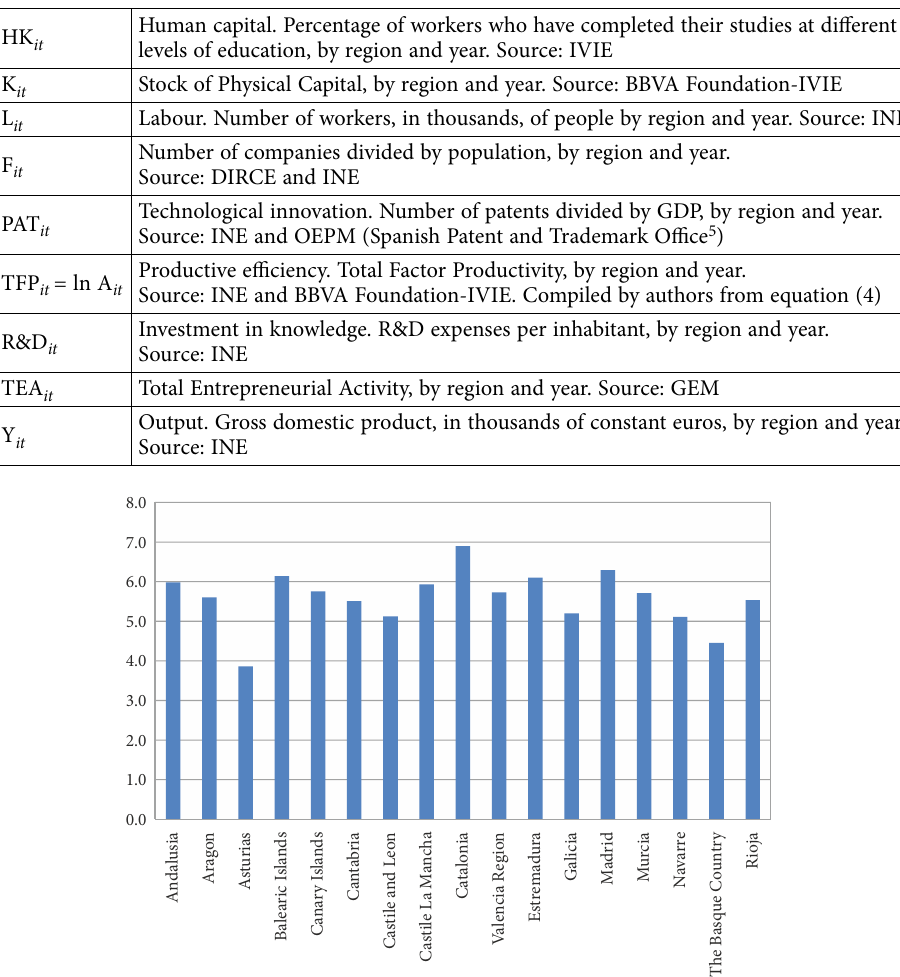
Table 1. Definition and sources of the variables used (source: compiled by the authors)